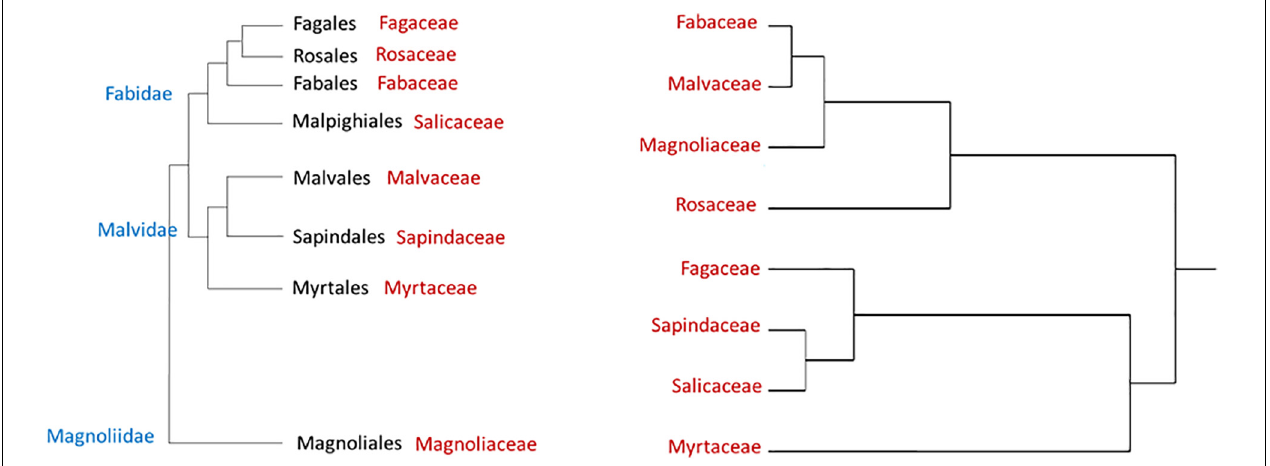
FIGURE 1 | Hierarchical clustering dendrogram of eight botanical families based on three susceptibility categories of tree species to PSHB (right, based on Table 4 ); as compared with phylogenetic tree of these families [left, according to Soltis et al. (2011)].